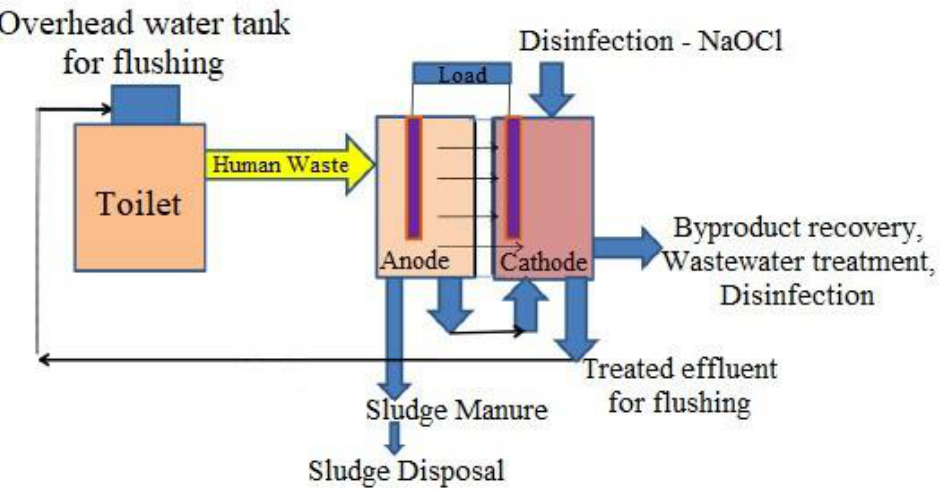
Figure 6. Flow chart depicting the efficient treatment of human waste in MFC.